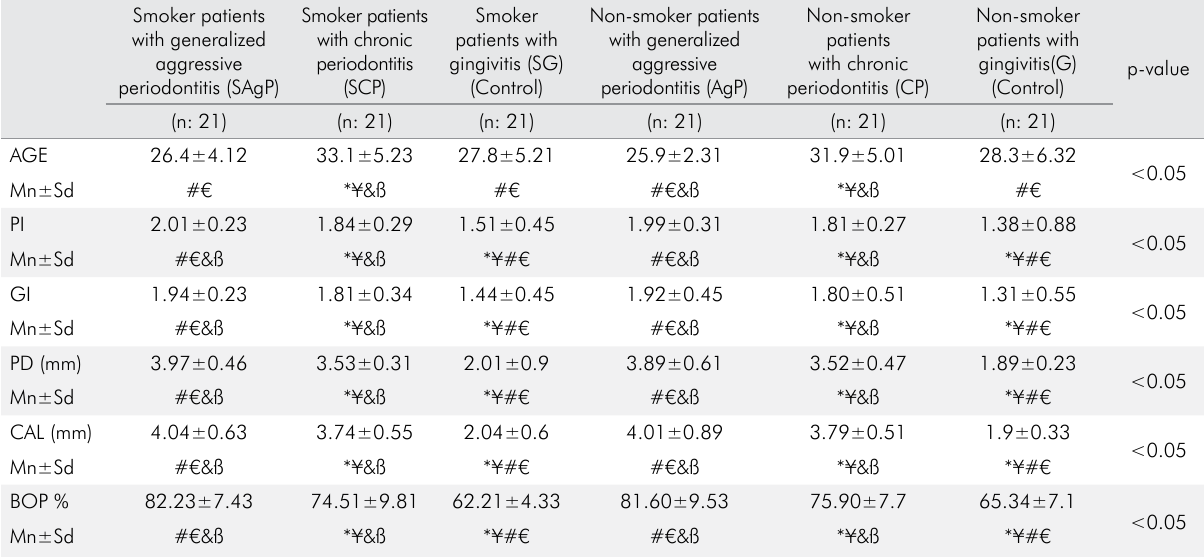
Table 1. Clinical Periodontal Measurements (All Mouth) and Age of the Study Groups (Mean±Standard deviation) Smoker patients with generalized aggressive periodontitis (SAgP)